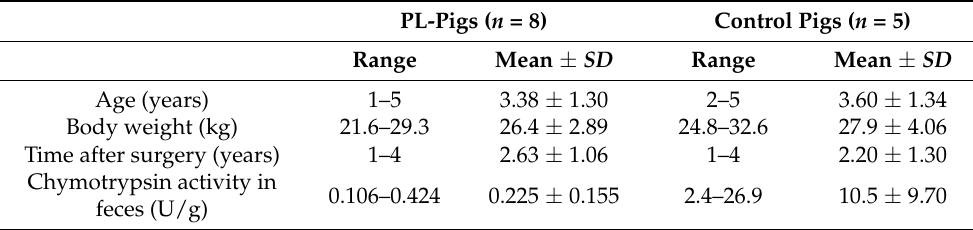
Figure 1. Schematic representation of the study set-up that used a porcine model of exocrine pancreatic insufficiency. During the experiment, pancreatic enzyme replacement therapy (PERT) was stopped and again re-administered in pancreatic duct ligated minipigs (PL-pigs). Ileal and fecal samples were taken during PERT ( n = 2 timepoints; days − 5 and − 1), during withdrawal of PERT ( n = 5 timepoints; days 1, 3, 5, 8, 10) and again after re-administration of PERT ( n = 2 timepoints; days +7, +14). Samples of ileal digesta and feces of ileo-cecal fistulated healthy minipigs (Control pigs) were taken at the beginning and end of the experiment. The sequencing of the 16S rRNA gene was conducted in obtained samples for microbiota analyses. The figure was created using biorender.com (accessed on 26 September 2022). Table 1. Characteristics of the minipigs enrolled in this